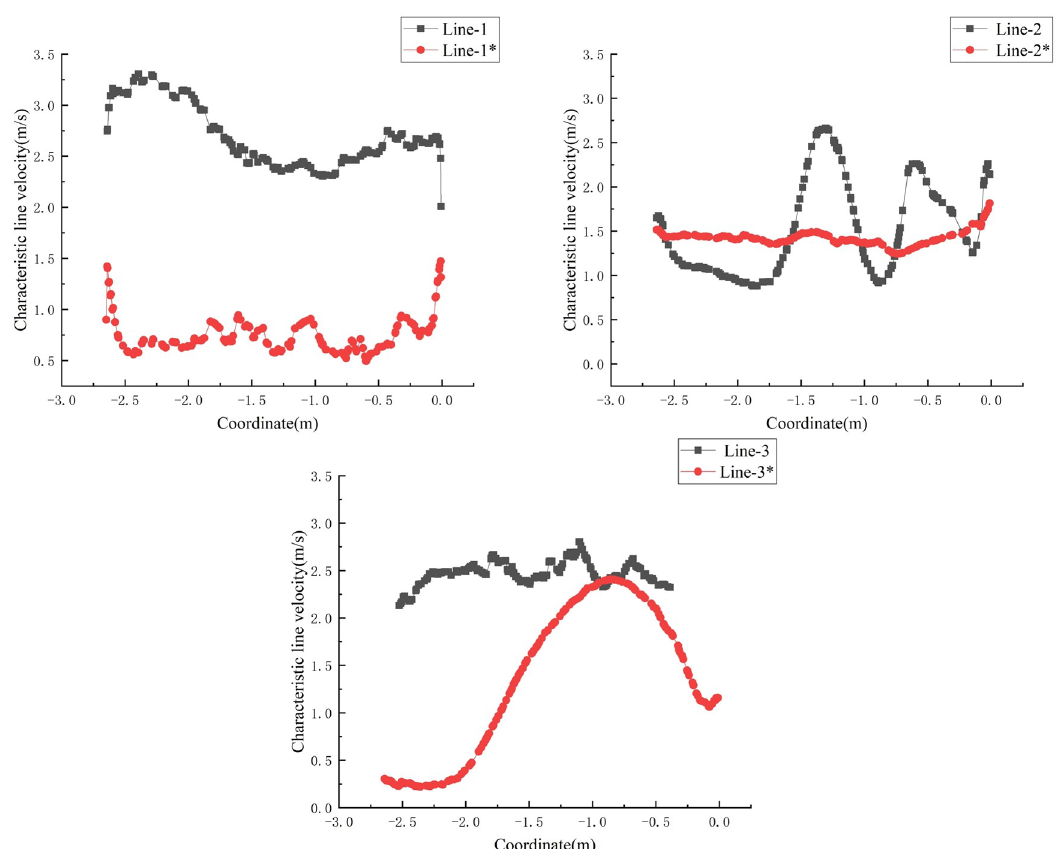
Fig 22. Comparison of the characteristic line speed of the same